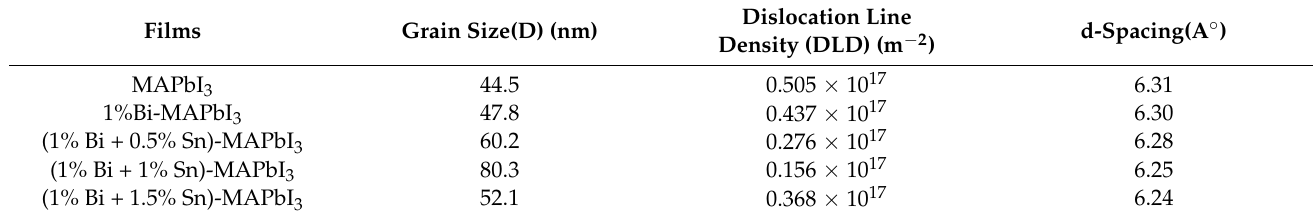
Figure 2. δ and D of pure and Bi-Sn co-doped MAPbI 3 . Table 1. D and δ of pure and Bi-Sn co-doped MAPbI 3 films.